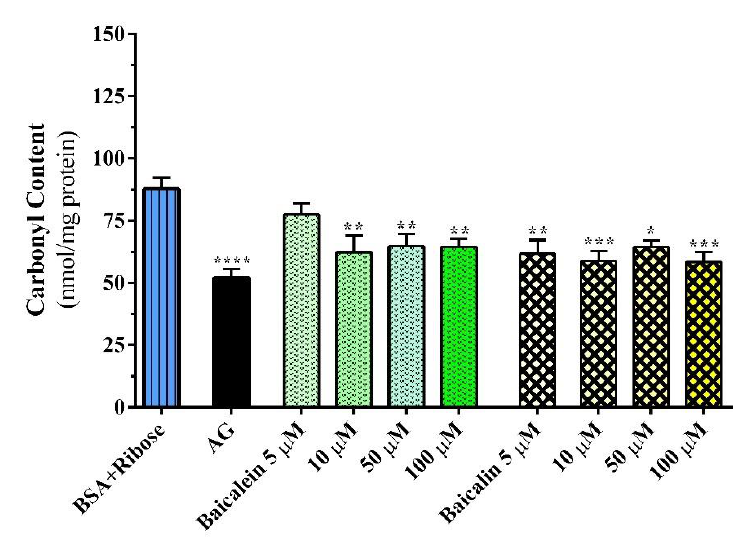
Figure 5. Effects of baicalein (green bars) and baicalin (yellow bars) on carbonyl content, detected with 50 mg/mL BSA and 0.1 M ribose, reported as carbonyl content and expressed in nmol/mg protein. Aminoguanidine (2.5 mM, AG) was the positive control. Data are the mean ± SEM of 3–6 experiments. * p < 0.05, ** p < 0.01, *** p < 0.001, and **** p < 0.0001 versus maximal carbonyl content (BSA + Ribose).